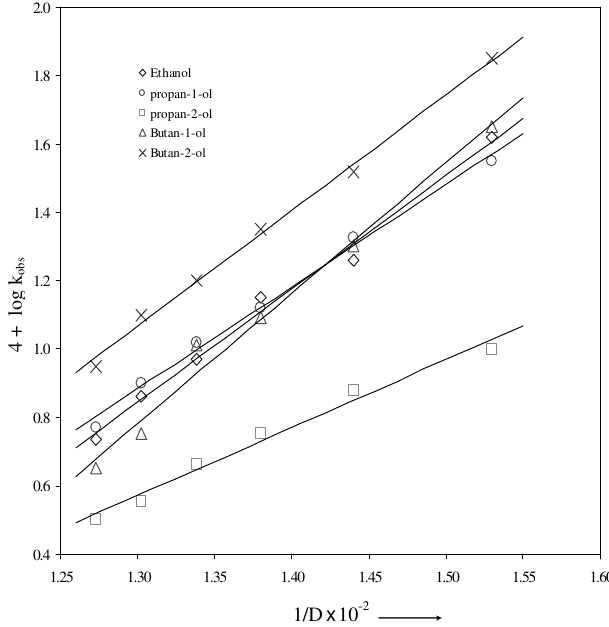
Figure 3. Variation of rate with solvent composition.